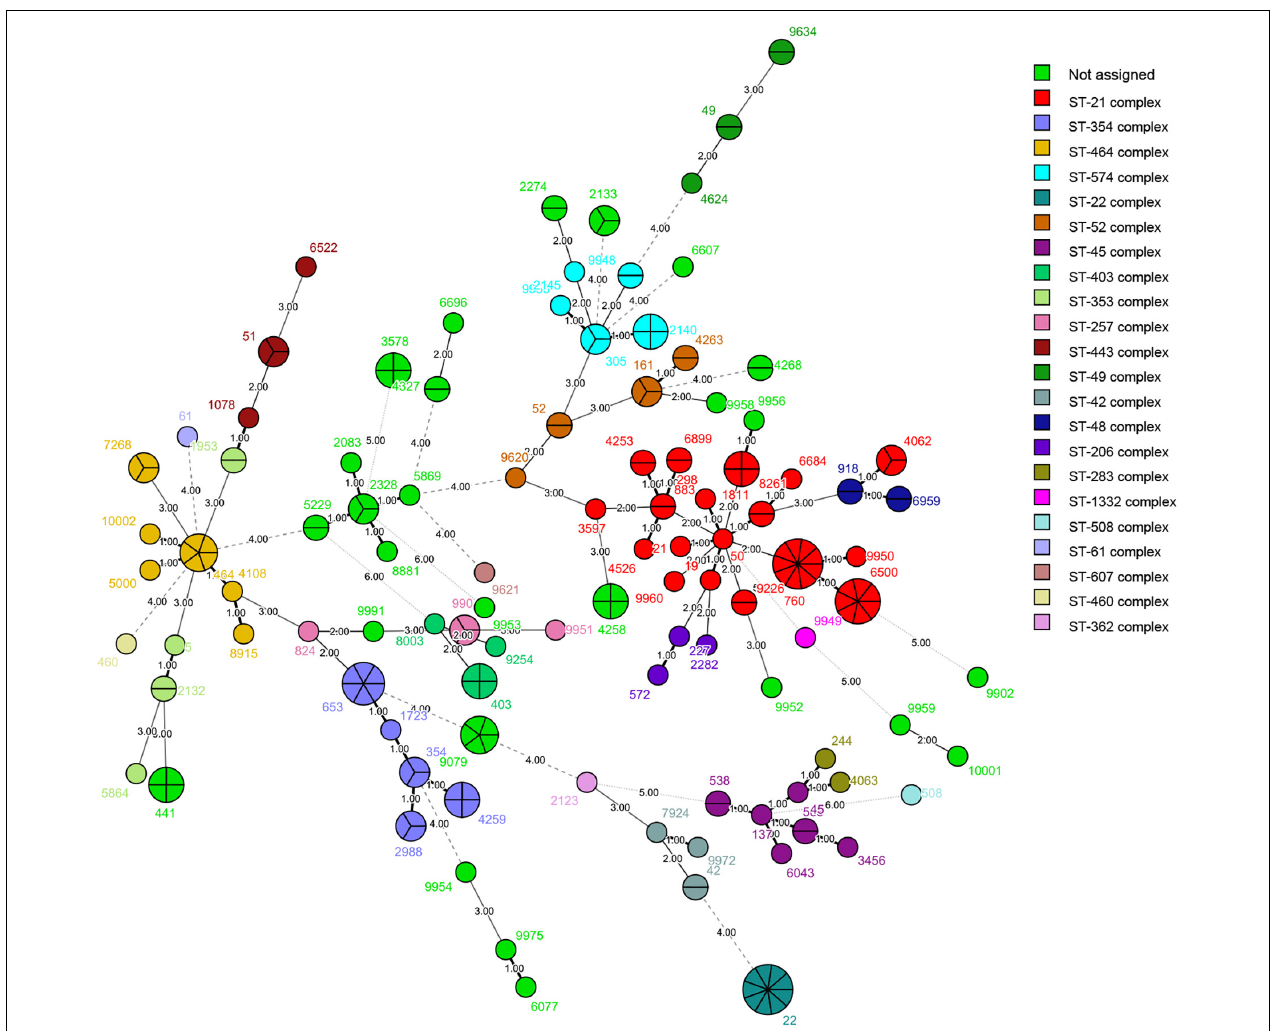
FIGURE 1 | Phylogenetic analysis. Minimum spanning tree (MST) of MLST data of 200 C. jejuni human isolates collected in 2017 and 2018 in Beijing, China. Each color represents one clonal complex (CC). Isolates are represented by circles, and the size of the circle is proportional to the number of isolates. Branches and numbers represent allelic differences between